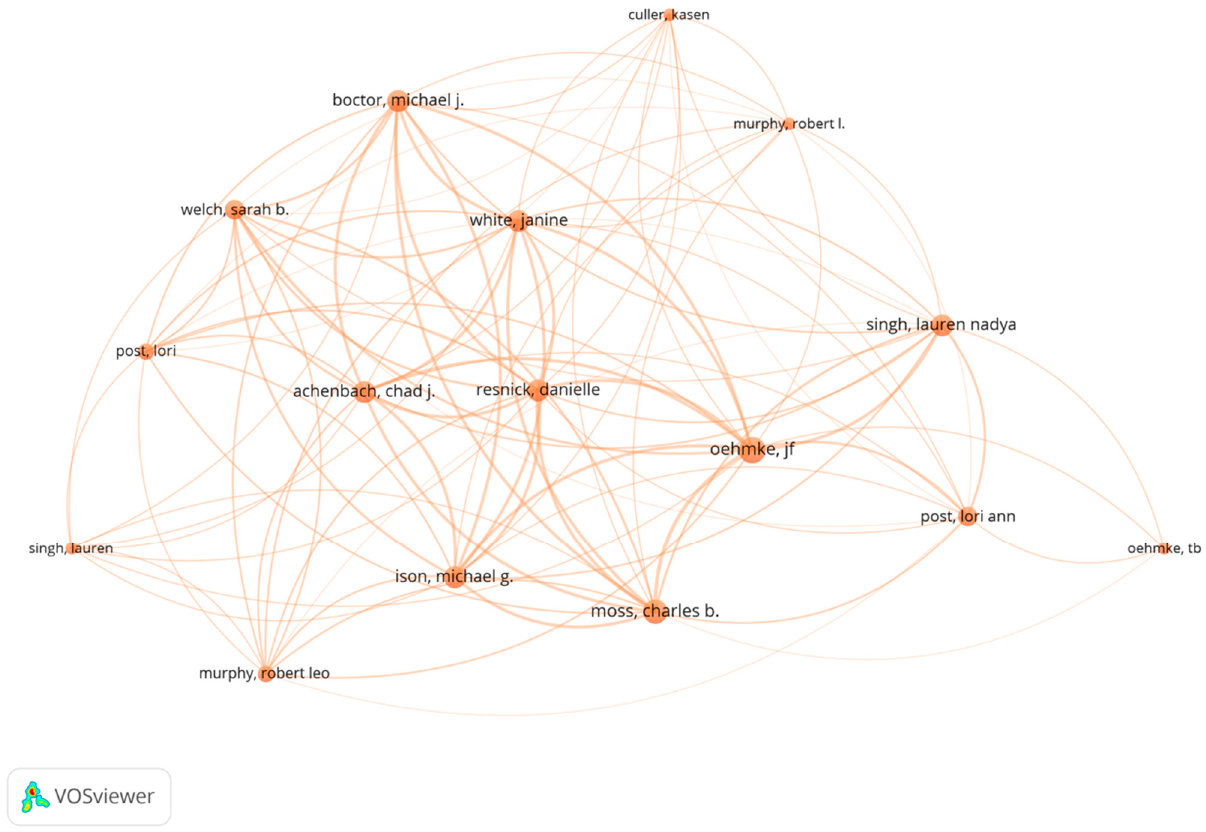
Figure 4. The co-authorship network (this is based on citations).